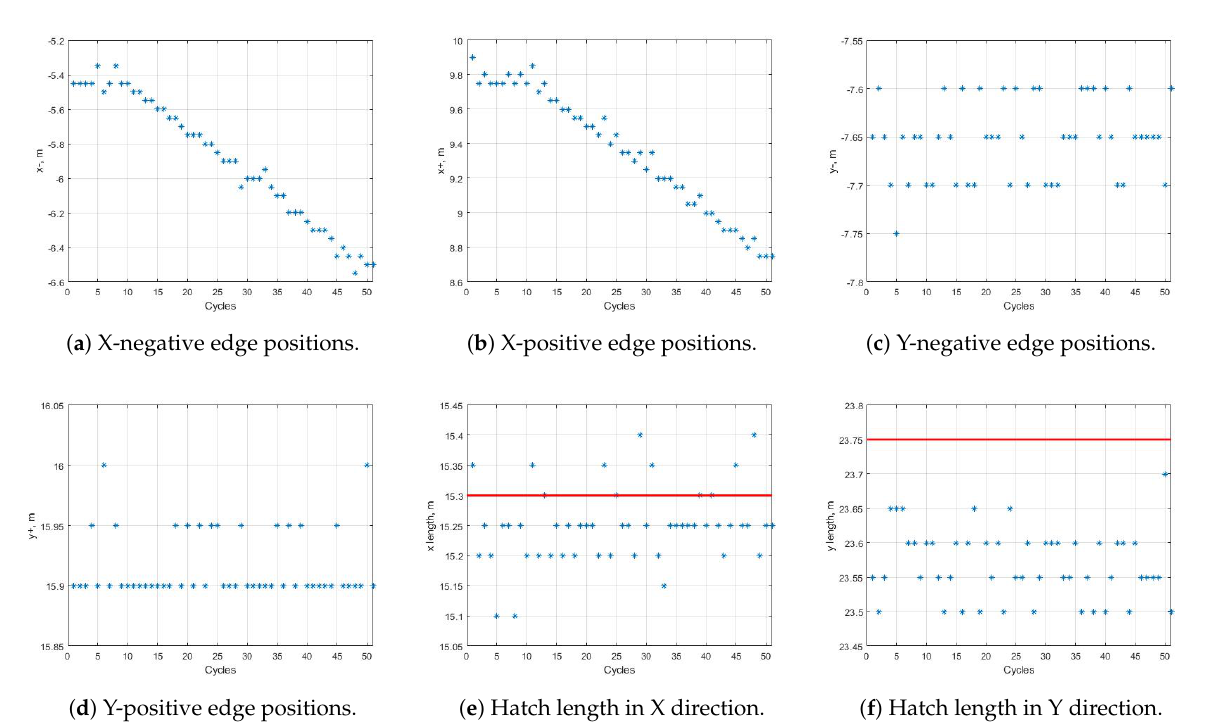
Figure 12. Measured hatch edge positions and sizes. Red lines indicate reference hatch length and